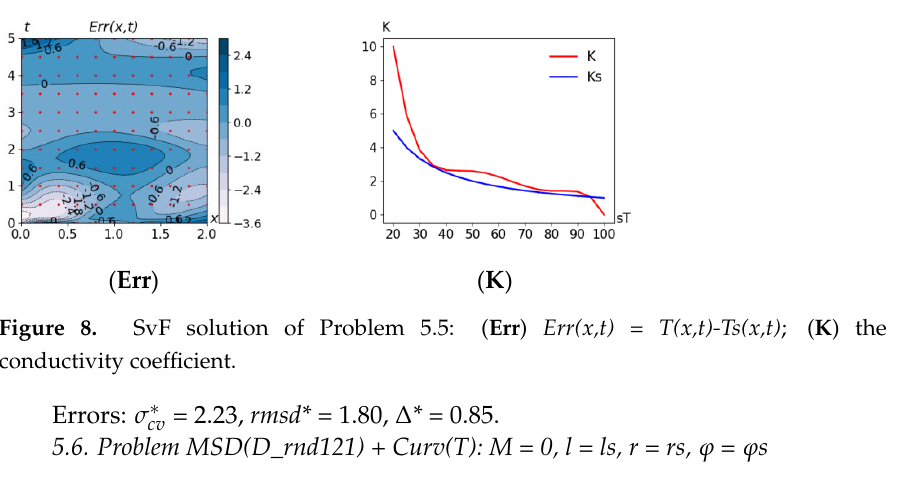
Figure 7. SvF solution of Problem 5.4: ( φ ) the initial condition; ( l&r ) boundary conditions; ( K ) the thermal conductivity coefficient.